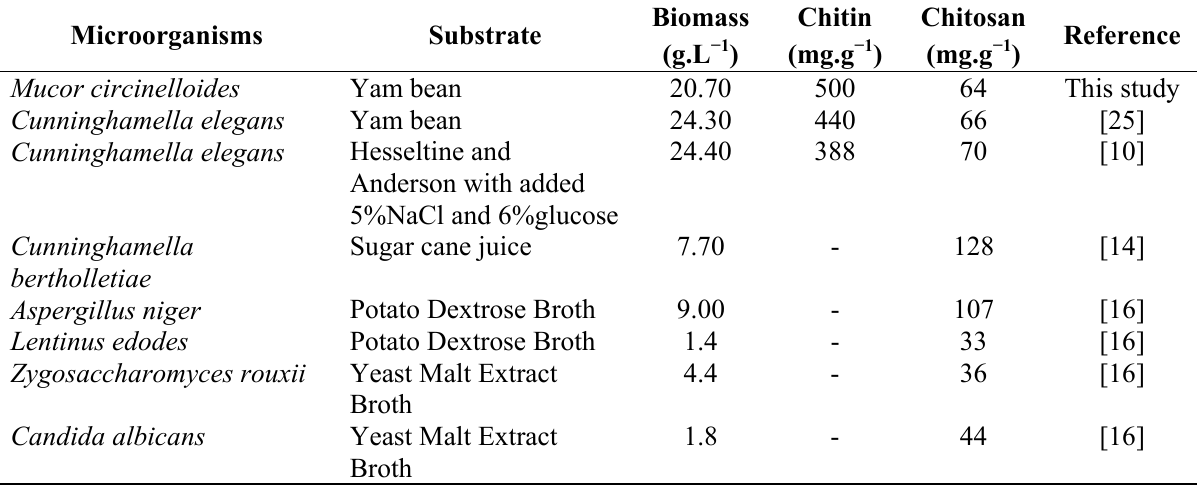
Table 2. Chitin and chitosan production by Mucor circinelloides using yam bean as substrate.